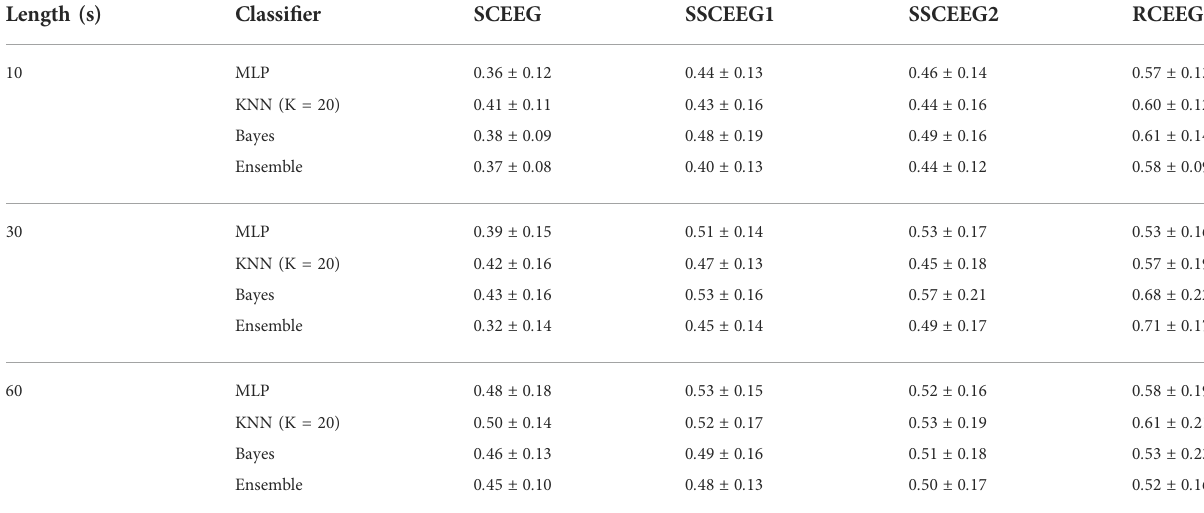
TABLE 8 PSD tr for simulated, semi-simulated and real EEGs at signal length 10, 30, and 60 s using four proposed classi fi ers. Length (s)